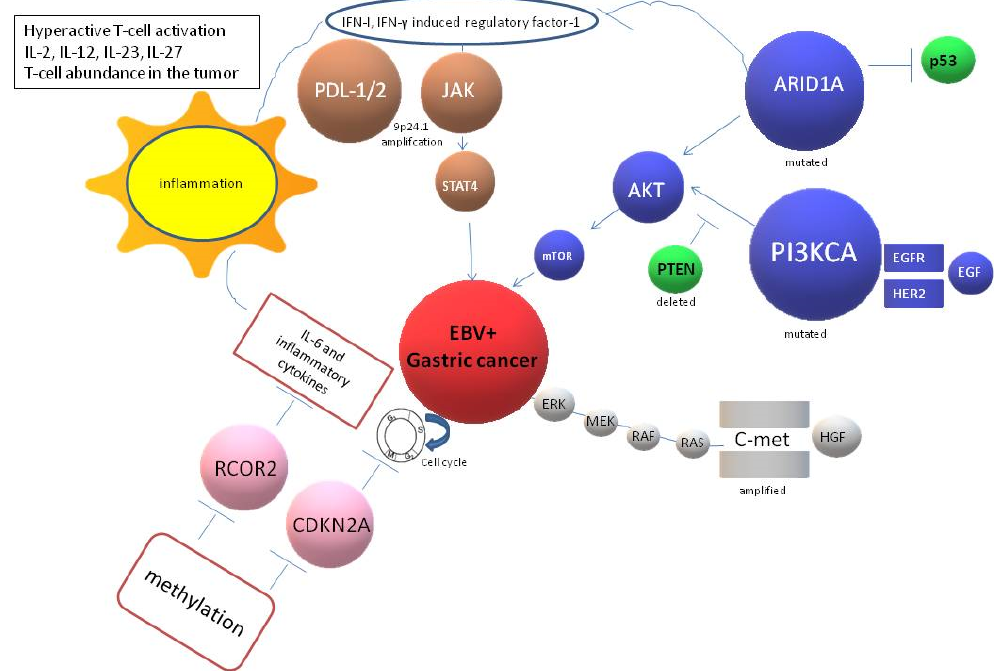
Figure 2. The most important signaling molecules characterizing EBV+ GC. There are four main signals known: (1) Gene mutations, mainly affecting the PIK3CA and ARID1A genes, which lead to an activation of the PI3K/Akt pathway; (2) activation of the tyrosine kinase pathway mainly due to amplification of the MET gene; (3) hypermethylation of several genes, in particular, RCOR2 and CDKN2A genes, which leads to the activation of cyclases and an increase in the inflammation surrounding the tumor site with an increase in reactive oxygen species (ROS) production and the release of several cytokines; and (4) amplification of the chromosome 9p24.1, including the PDCD1L 1-2 and JAK2 genes.